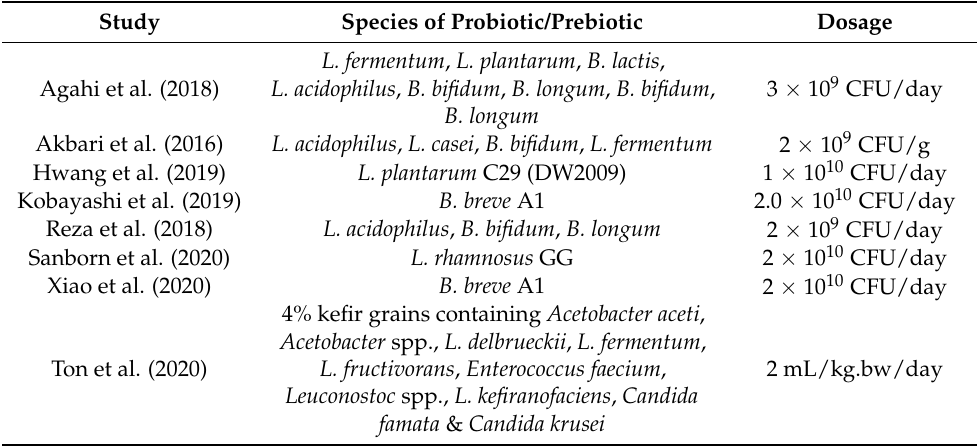
Table 3. Species and dosage of probiotic/prebiotic used in the included studies.